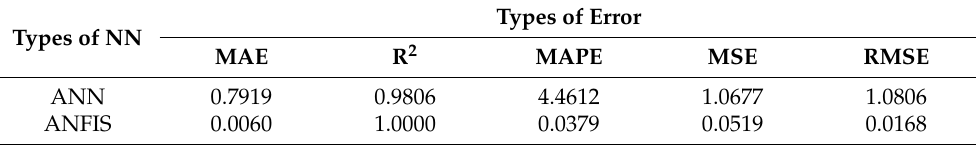
Table 9. Comparison analysis of ANN and